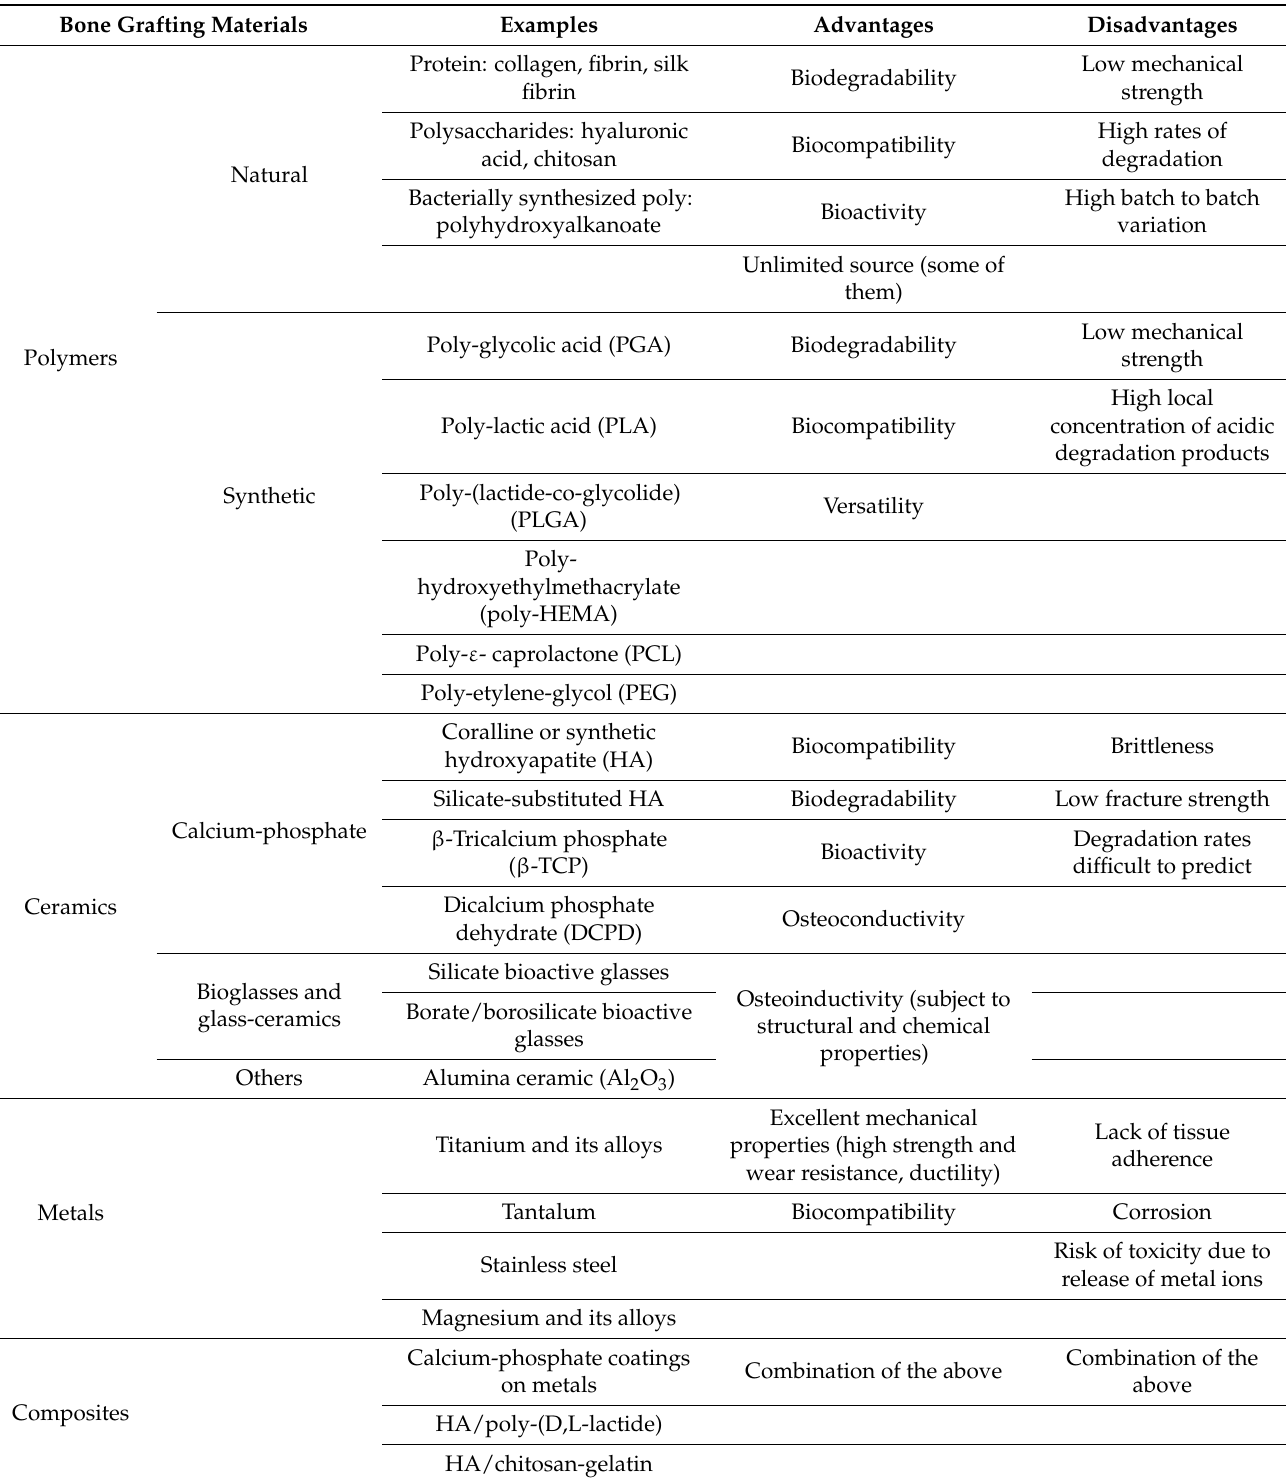
Table 1. The materials, examples, advantages, and disadvantages of scaffolds in BTE